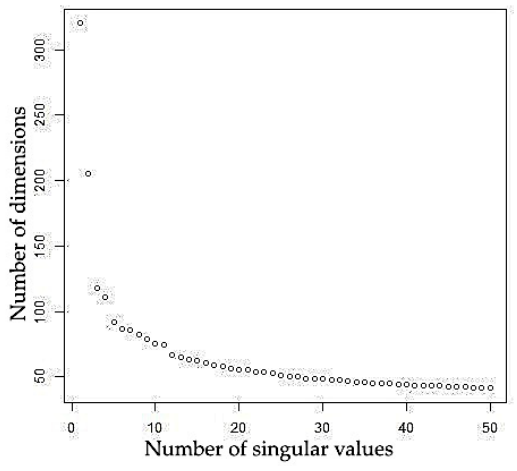
Figure 2. Scree plot for SVD of the user-like matrix.